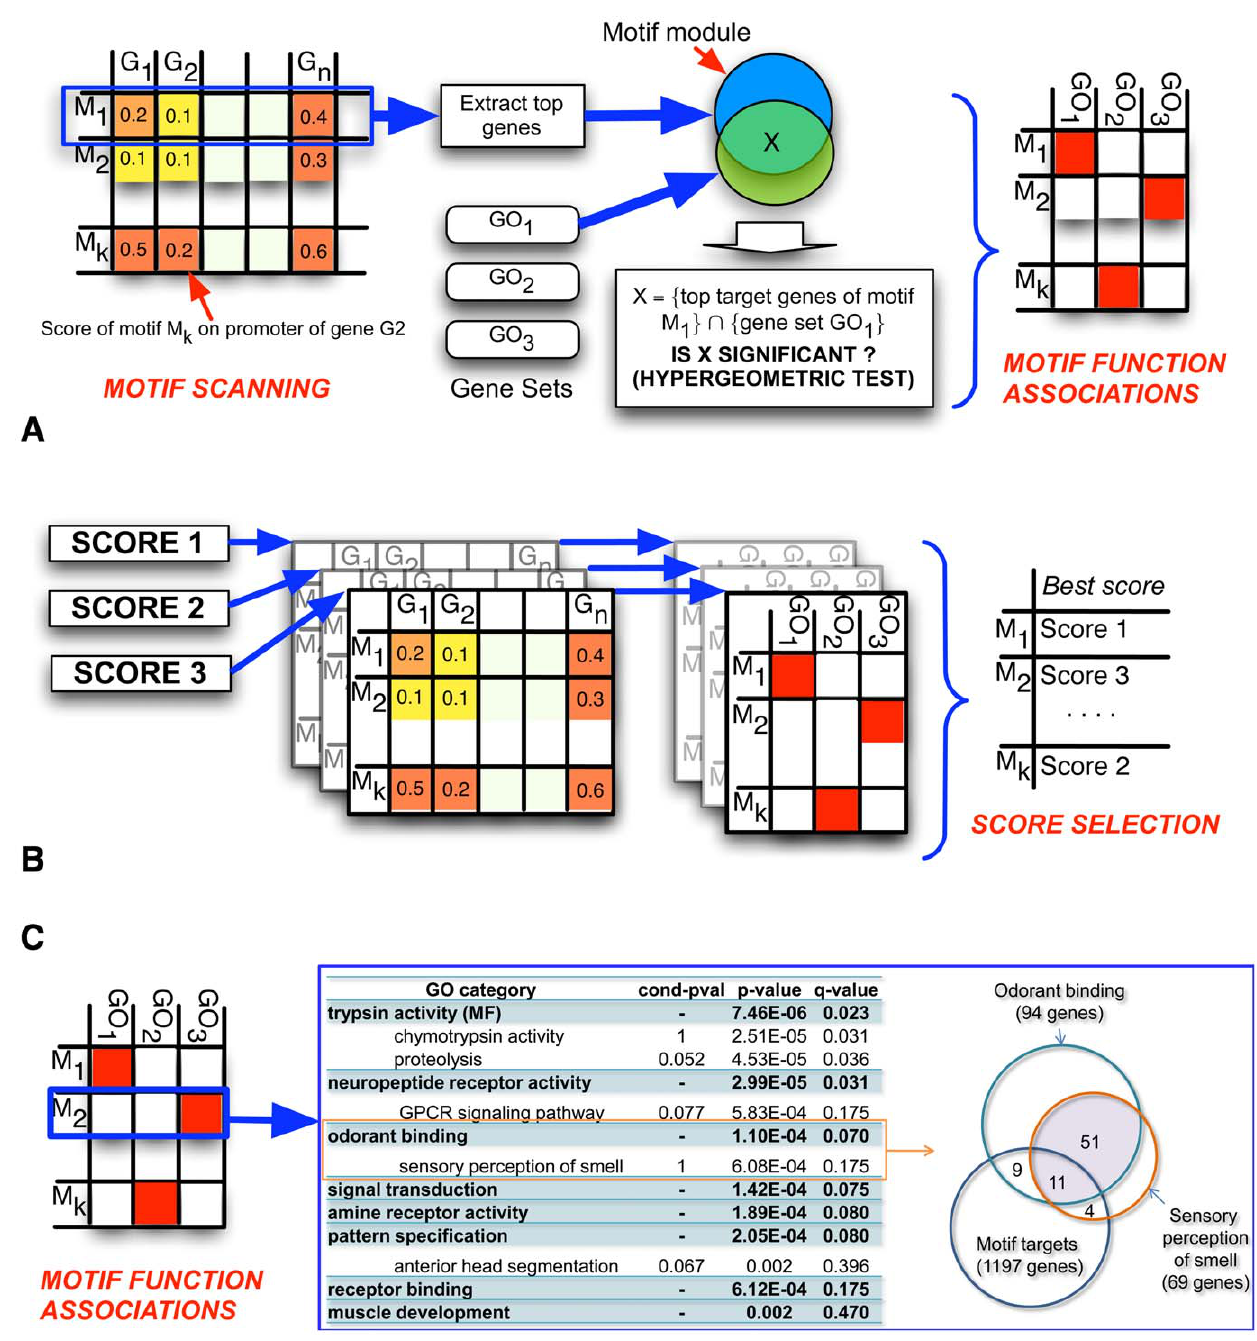
Figure 1. Computational pipeline for charting a motif function map. (A) Each motif is scored against each gene’s promoter (‘‘motif scanning’’). The top scoring target genes of a motif (‘‘motif module’’) are analyzed for enrichment for GO gene sets using the Hypergeometric test, and statistically significant motif – GO associations (red cells) from the test constitute a ‘‘motif function map’’. (B) Different motif scanning methods produce different motif function maps by the process in (A). For each motif, the best motif scanning method (score) is selected by evaluating each motif function map based on the number of associations and a suitable control (see Methods). (C) For each motif, redundant GO associations are identified by using an extended Hypergeometric test (see Methods) and the motif function map is reorganized. This panel shows GO associations of the Fushi tarazu (FTZ) motif, with redundant associations being indented. The ‘‘cond-pval’’ column is the conditional p-value of an association given the stronger association it is redundant with (see Methods). For example, the association with ‘‘sensory perception of smell’’ is highly significant (p- value , 6E-4), but is ‘‘statistically explained’’ by the association with ‘‘odorant binding’’ (conditional p-value , 1); the Venn diagram on the right illustrates why this is the